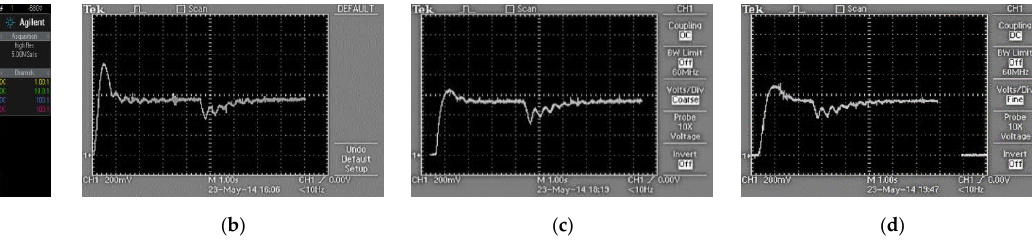
Figure 15. Five-phase PMBLDC drive waveforms (Experimental). ( a ) Line Voltage Vab,Vbc and Phase-a, Phase-b currents. ( b ) Speed Response of PI Controller fed Drive. ( c ) Speed Response of Fuzzy controller fed Drive. ( d ) Speed response of Fuzzy-PI controller fed Drive.